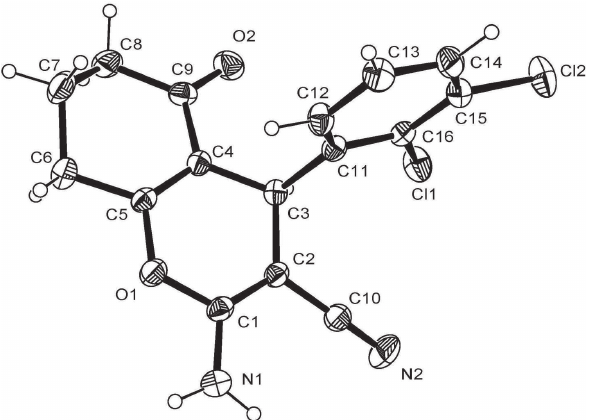
Table 2: Fractional atomic coordinates and isotropic or equivalent isotropic displacement parameters (Å 2